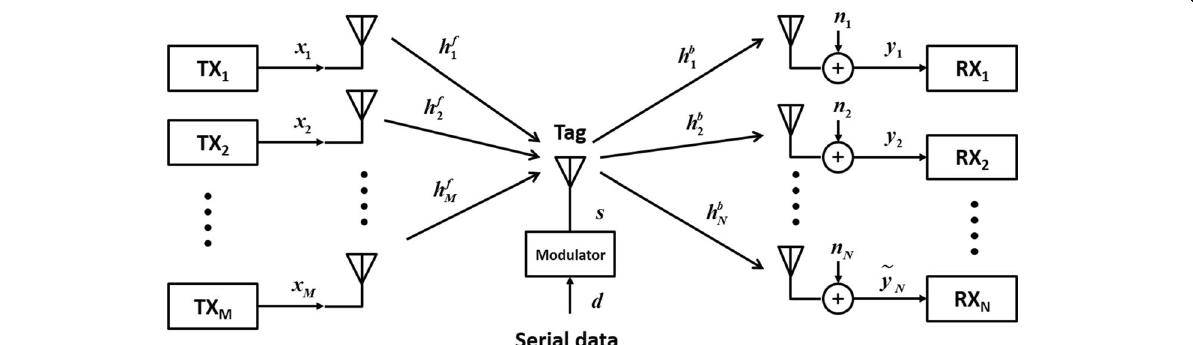
Fig. 2 Scheme of a conventional M × 1 × N cascaded backscatter